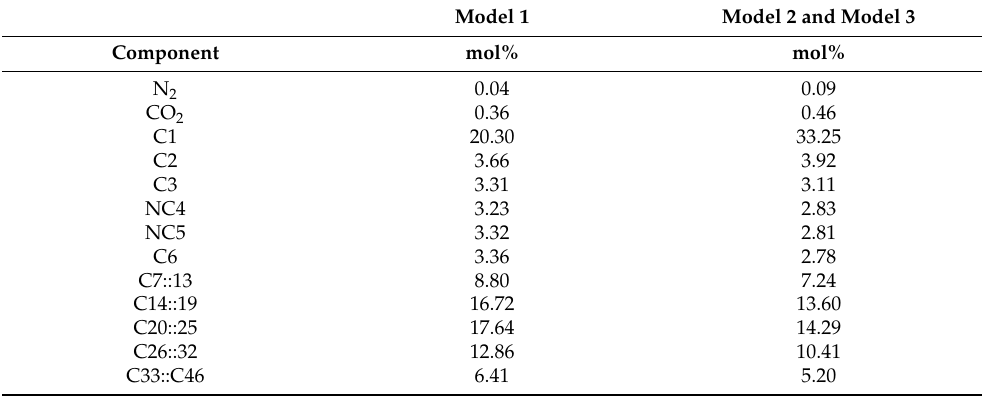
Table 3. Oil composition for